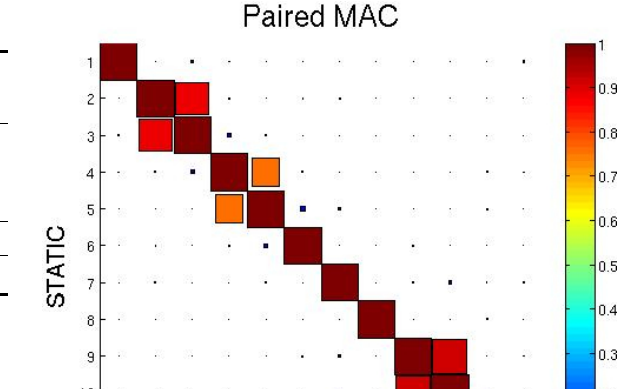
Table 3: FE model — elements, nodes and DOFs